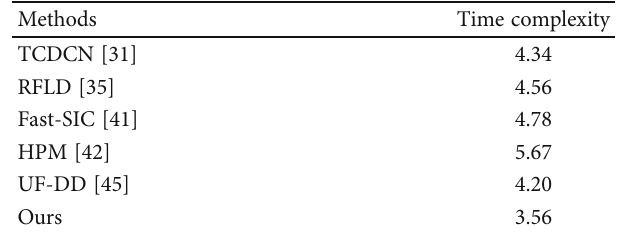
Table 3: Comparison of time complexity in